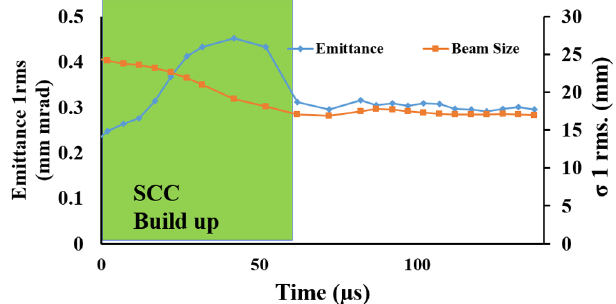
FIG. 3. H − emittance and beam size evolution in time due to SCC using the SCC - SPI code for a 30 mA beam with 50 keV energy.